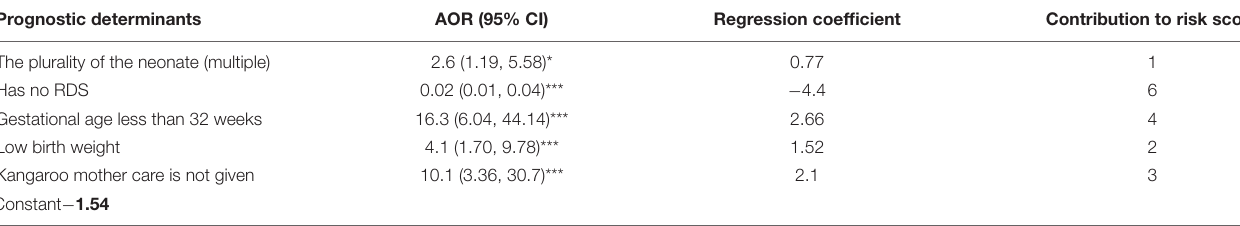
TABLE 6 | Prognostic determinants in south Gondar zone public hospitals, northwest Ethiopia, 2021. Prognostic